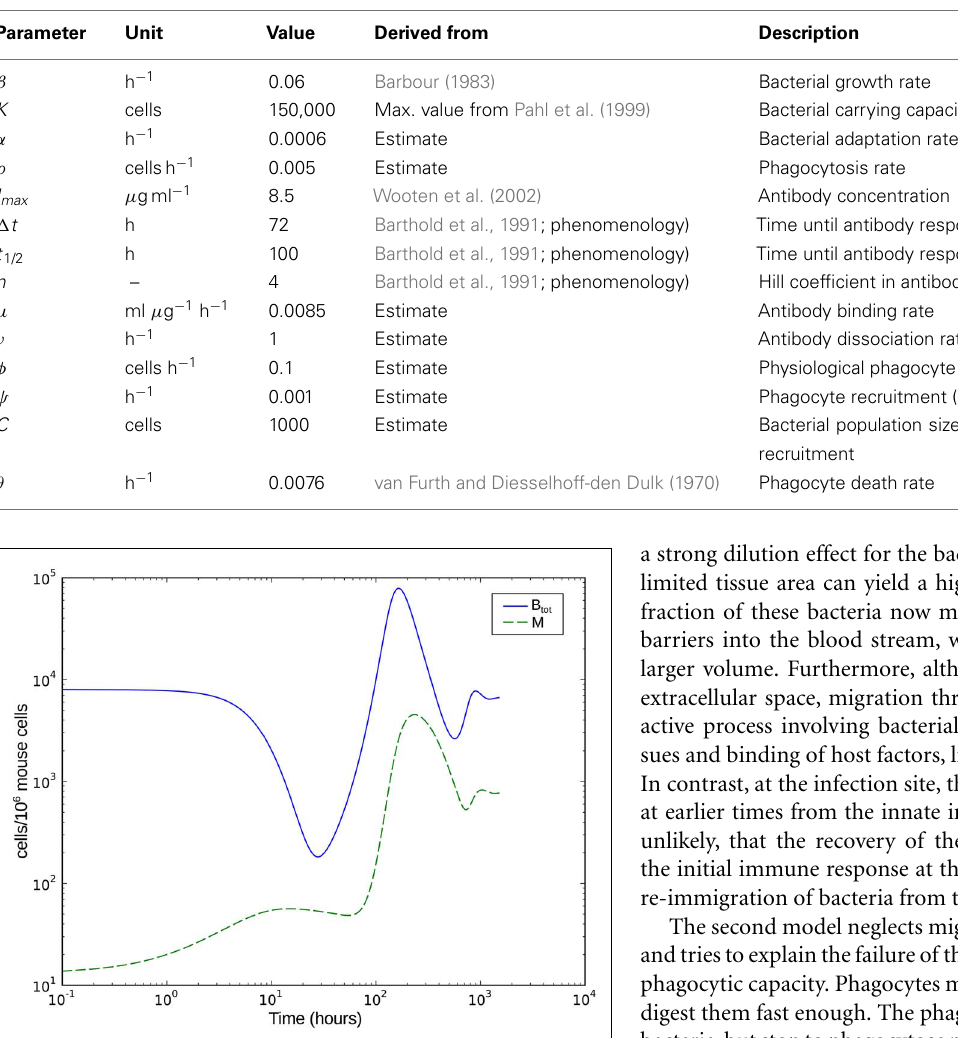
Table 2 | Parameters used for the numerical simulations in Figure 7A.